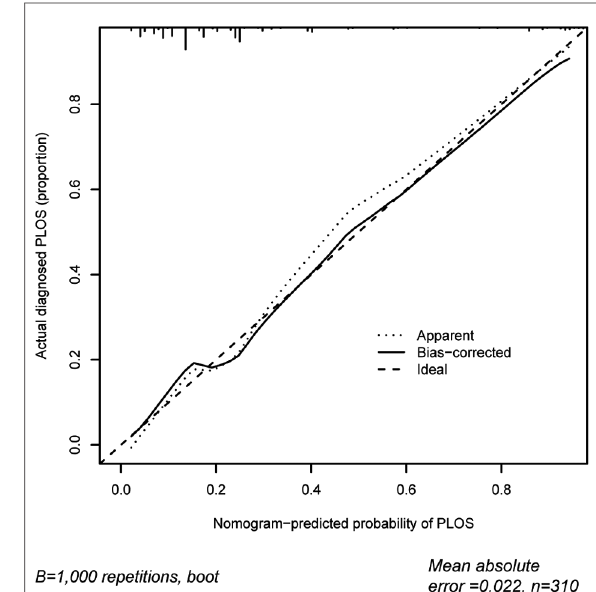
FIGURE 4 ROC of a predictive nomogram model. The ROC of this model was drawn with the variables of BMI, diabetes, hypertension, duration of operation, duration of anesthesia, anesthesia type, estimated blood loss, dose of sufentanil for postoperative analgesia, and postoperative complication by MedCalc (Version 19.2; https:// www.medcalc.org). PLOS, postoperative length of stay; BMI, body mass index.